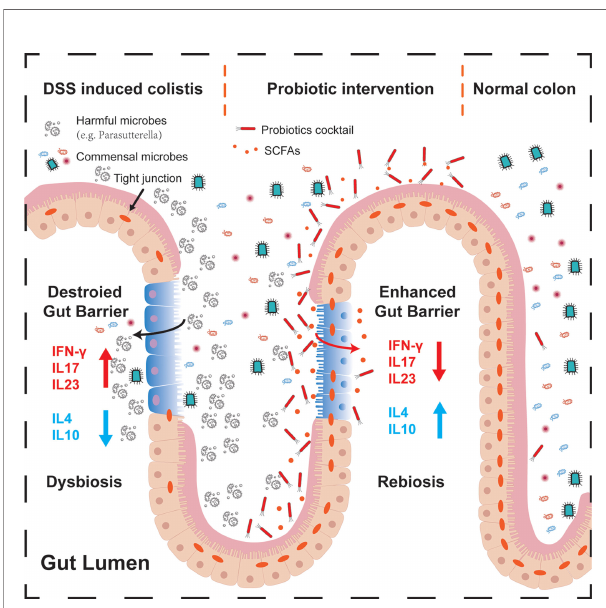
FIGURE 6 | Schematic summary of the probiotic cocktail for alleviating acute intestinal in fl ammation. During the process of acute in fl ammation (left part), harmful bacteria may attach to the injured intestinal epithelium, inhibiting commensal microbes to colonize and make function, destroying the gut barrier and tight junction proteins by regulating pro- or anti-in fl ammatory factors. After probiotics intervention (middle part), colonized butyrate- producing probiotics Bi fi dobacterium , together with the associated SCFAs, alleviated the progression of acute intestinal in fl ammation through enhancing the intestinal barrier, regulating the muti-in fl ammatory factors, and expelling potential pathogenic bacteria. In the normal colon (right part), balanced commensal microbes interacted with the intestinal mucosa, contributing to the dynamic balance of host